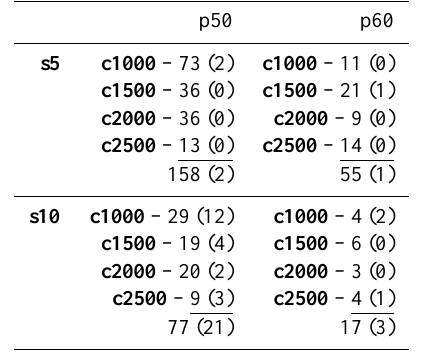
Table 3. Co-occurrence of specific value ranges of CAPE (c1000, c1500, c2000 and c2500), SHEAR (s5 and s10) and PW (p40 and p50) at the southern and northern sites for summer months of 2000– 2011. The counts of the co-occurrence for the southern sites are given after the CAPE case names and followed by that of the north- ern sites given in the parenthesis. The co-occurrences for a specific SHEAR and PW category are listed below all the CAPE cases in the